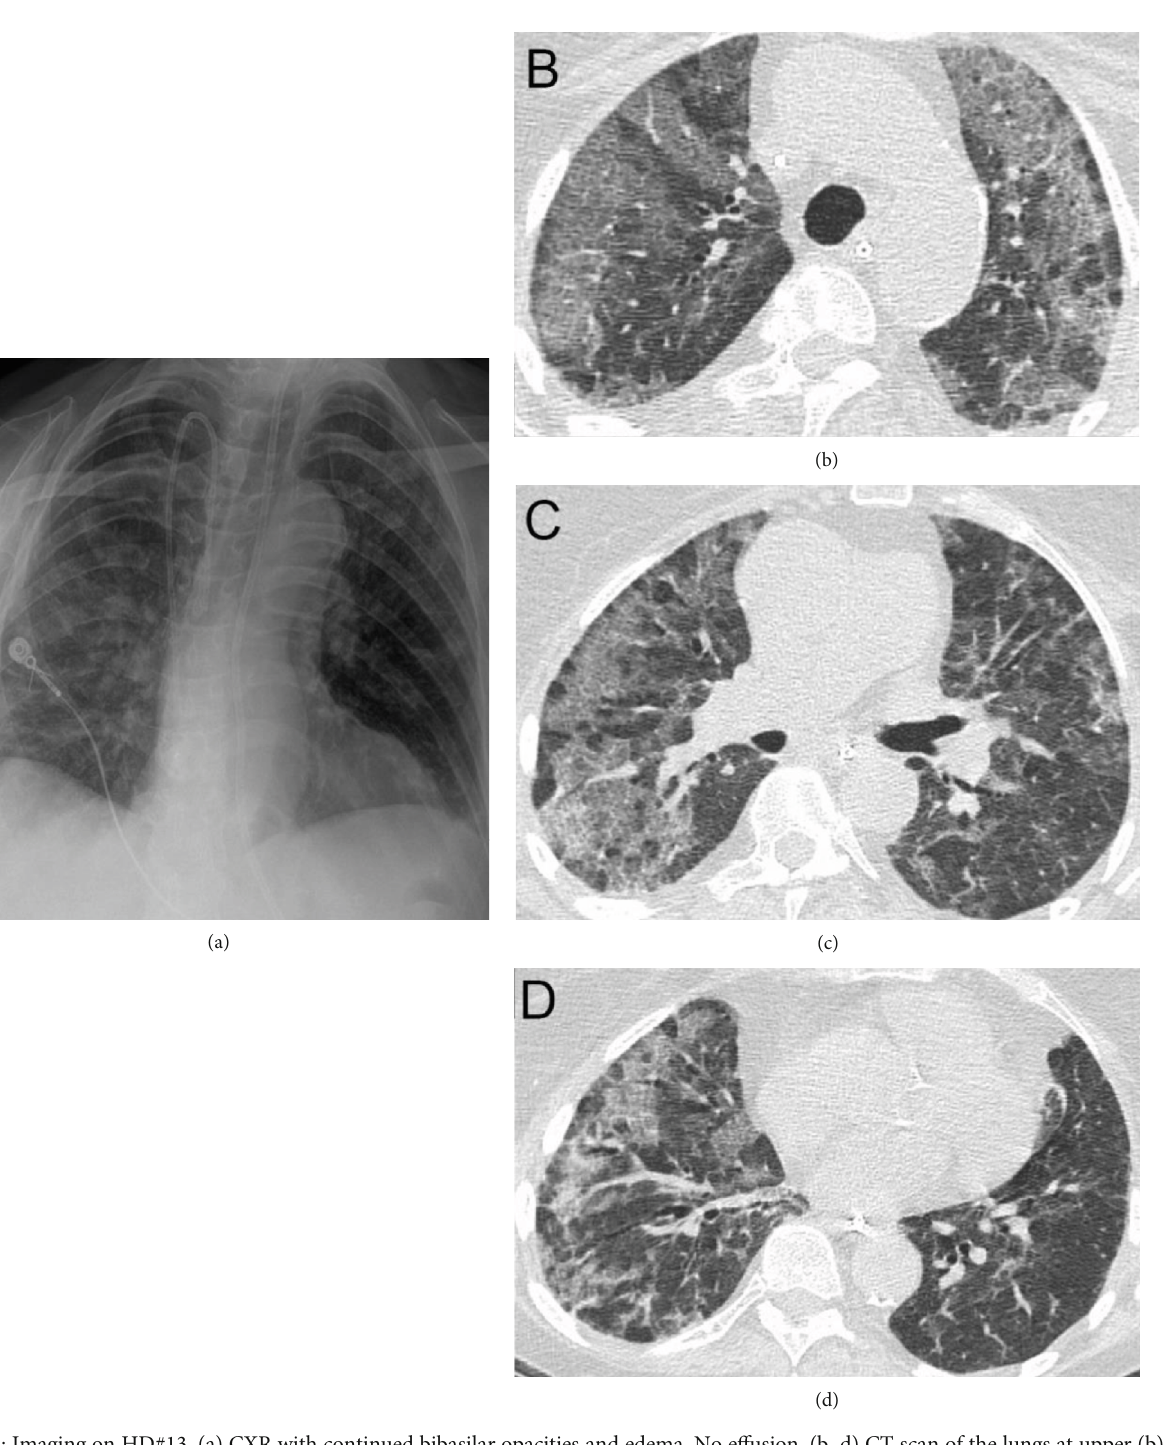
Figure 2: Imaging on HD#13. (a) CXR with continued bibasilar opacities and edema. No e ff usion. (b – d) CT scan of the lungs at upper (b), mid (c), and base (d) illustrating increased severity of ground glass airspace